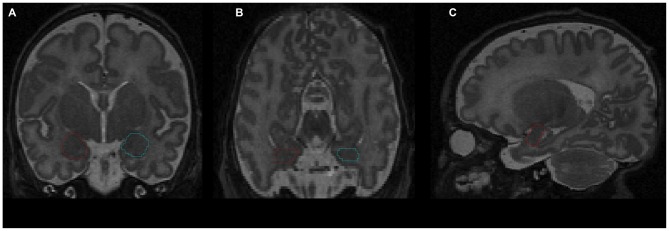
Delineation of amygdala on T2-weighted magnetic resonance imaging (MRI) using the Amira software: (A) coronal view; (B) axial view; (C) sagittal view. Red contour—right amygdala, blue contour—left amygdala.